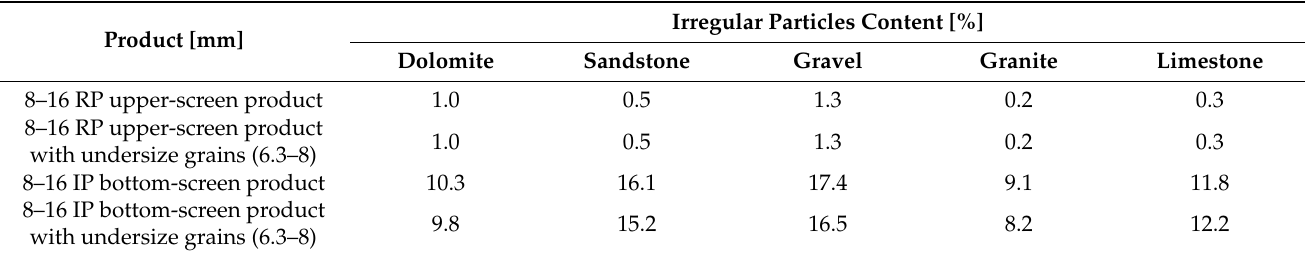
Table 7. The flakiness index (FL) values of products received from conventional crushing and screening of plants compared with those received from the innovative one. Irregular Particles Content [%] Product [mm] Dolomite Sandstone Gravel Granite Limestone